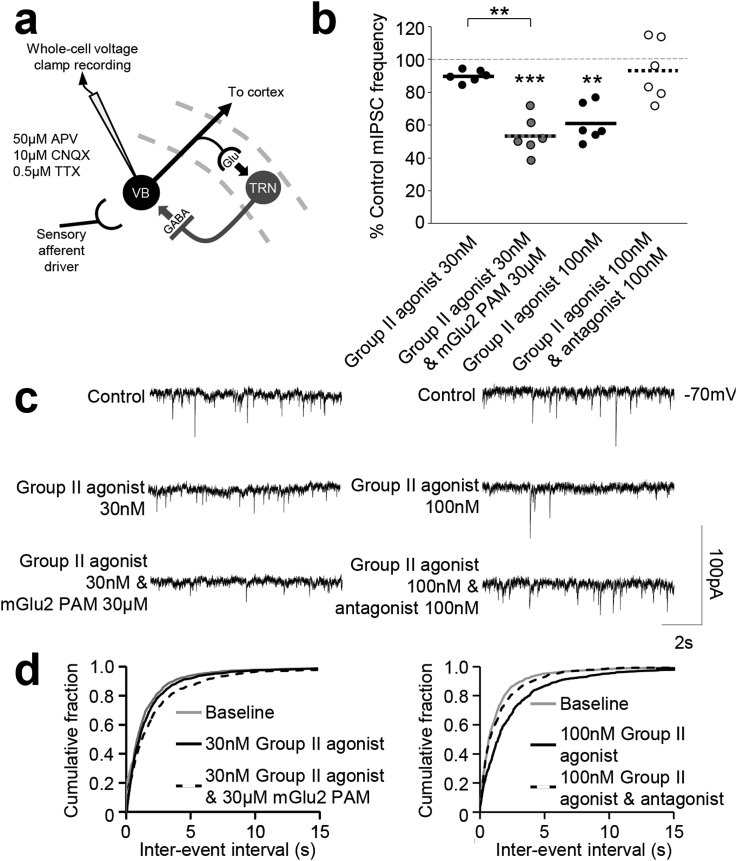
The Group II mGlu receptor effect on spontaneous presynaptic quantal release events includes an mGlu2 receptor-mediated component. a Circuitry between the TRN and VB with recording site indicated. b Effects of the Group II agonist LY354740 (30 nM) alone or in conjunction with the mGlu2 PAM LY487379 (30ìM) on the total number of spontaneous mIPSC events (final 5 min bin) in the VB. Specificity of the Group II agonist effect was confirmed upon its reversal using the Group II antagonist LY341495 (100 nM). c Traces from individual neurons illustrating the mean responses of neurons to the same conditions as described in b. d Effects of the same compound application combinations on the cumulative fraction of the calculated inter-event intervals of the spontaneous mIPSCs in the VB. **p < 0.001; ***p < 0.0001; Glu – glutamate.